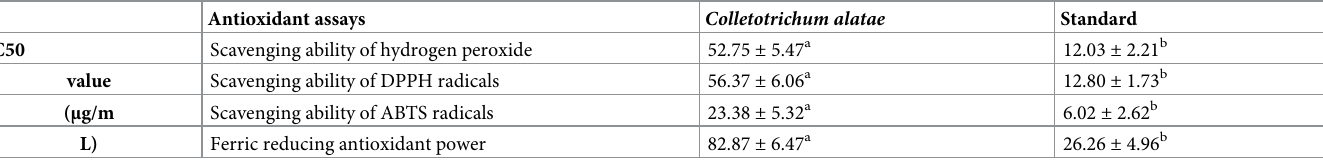
Table 7. Antioxidant activity of Colletotrichum alatae LCS1 methanolic culture extract isolated from Lycopodium clavatum